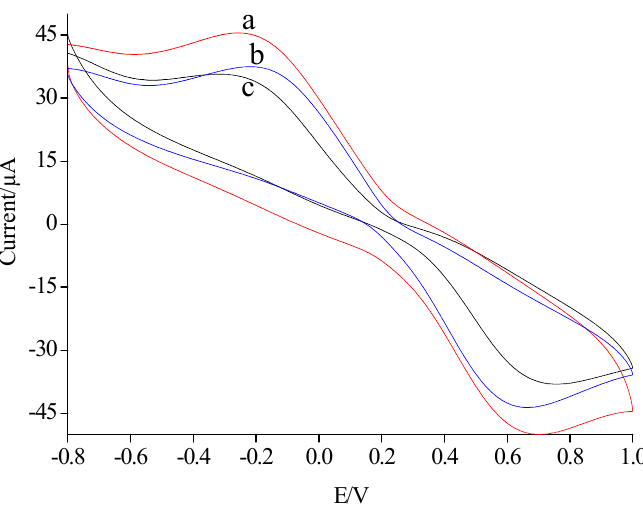
Figure 1. Cyclic voltammograms of SiSG/GCE (a) and Ab/SiSG/GCE (b), Ab/SiSG/GCE incubated in 10 μ g/mL of carbofuran for 20 min (c) in the presence of 0.01 M pH 7.0 PBS and 5.0 mmol/L [Fe(CN) ] 3 − /4 − . The scan rate was 100 mV/s. 6